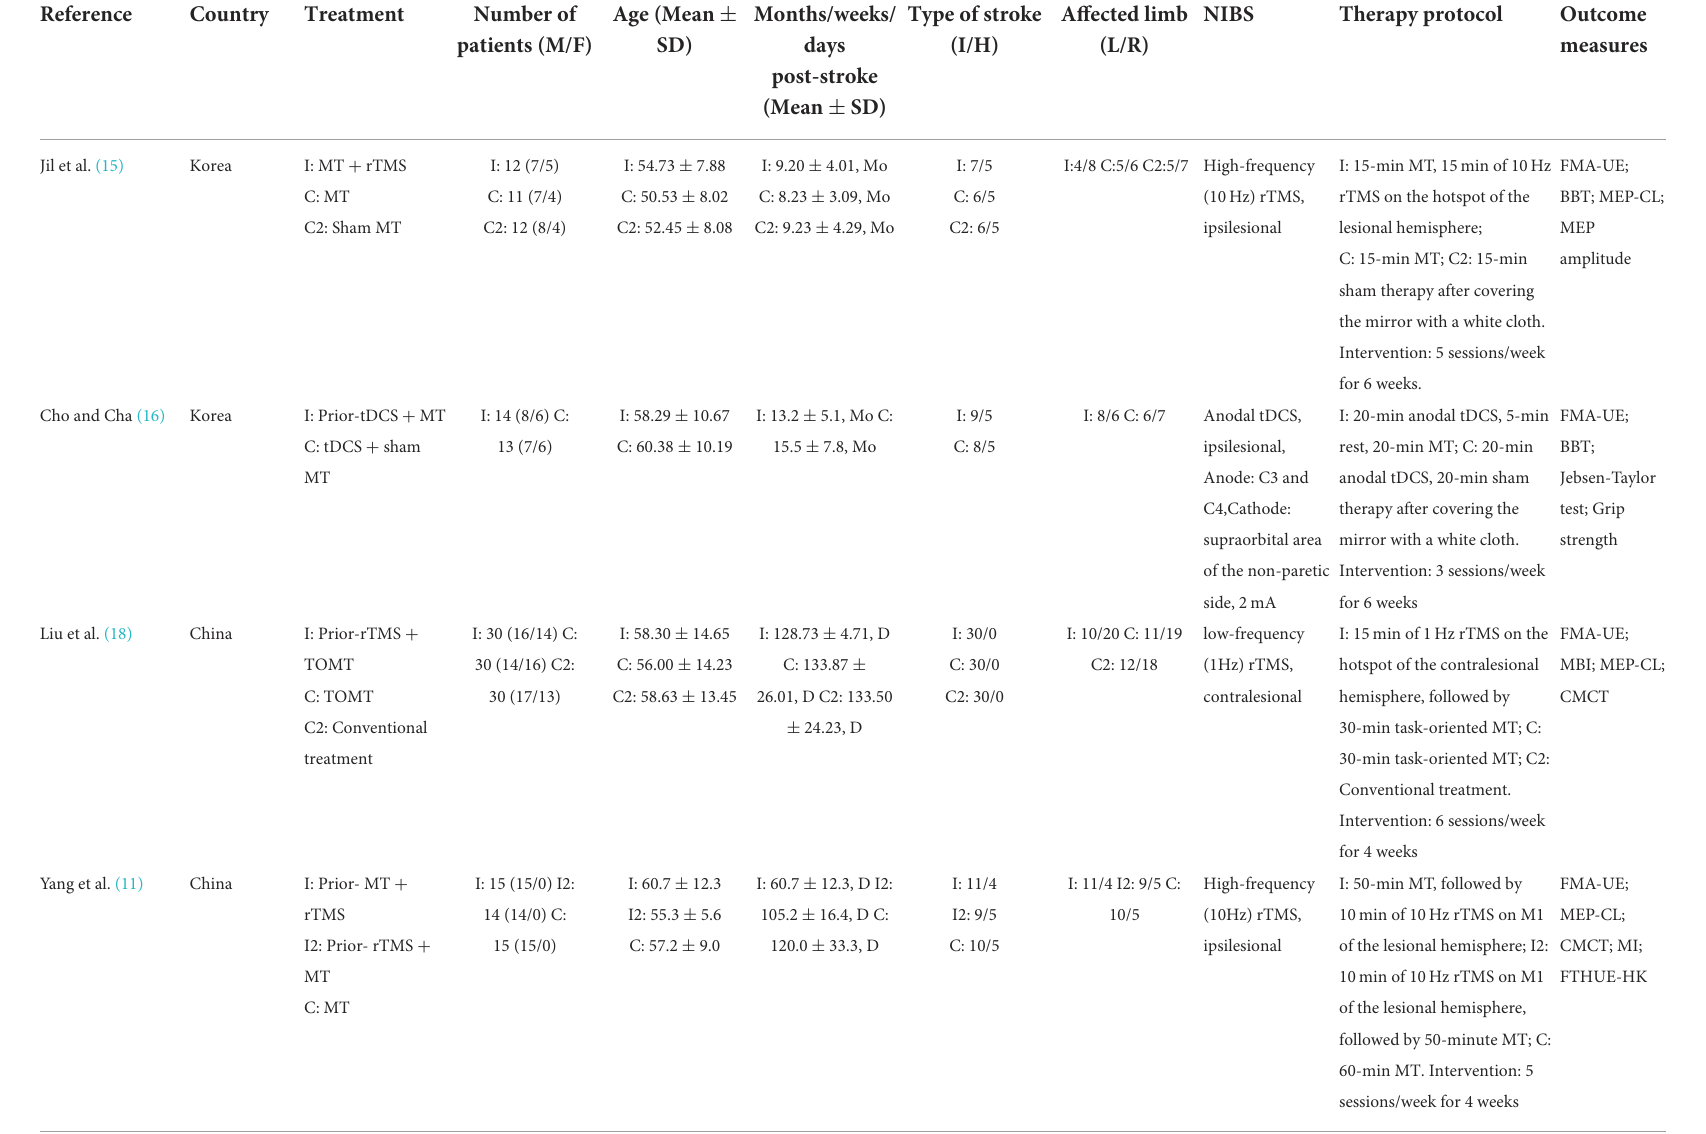
TABLE 1 Key characteristics of the studies included in the systematic